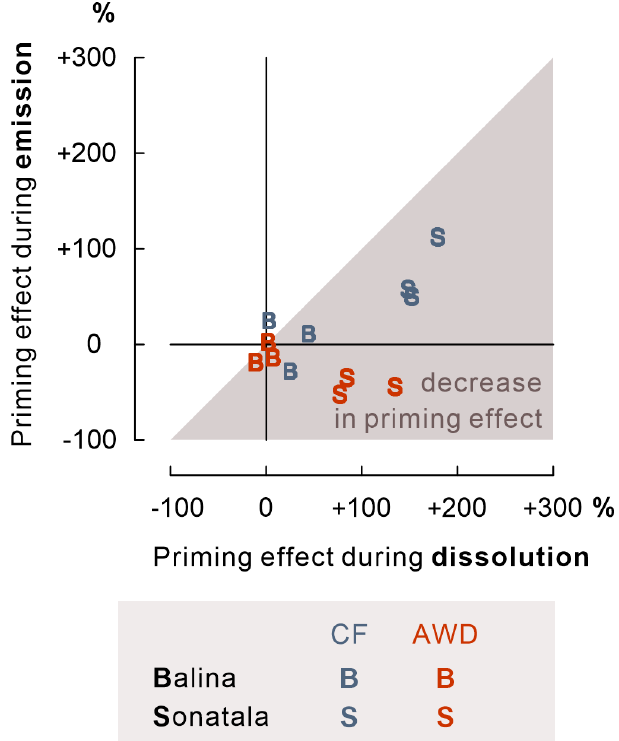
Figure 8. For Sonatala ( P < 0 . 001) and not significantly for Balina ( P = 0 . 18), the priming effect on gaseous C (CO 2 + CH 4 ) emission was lower than on SOC